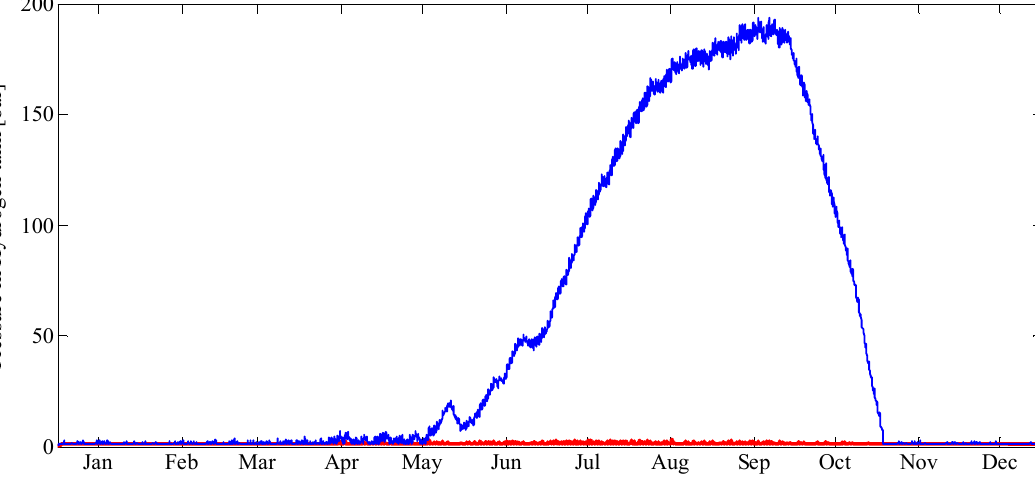
Figure 9. Pressure in the hydrogen storage tank. Blue curve is at 50 m 2 PEC size while red is only 18 m 2 .